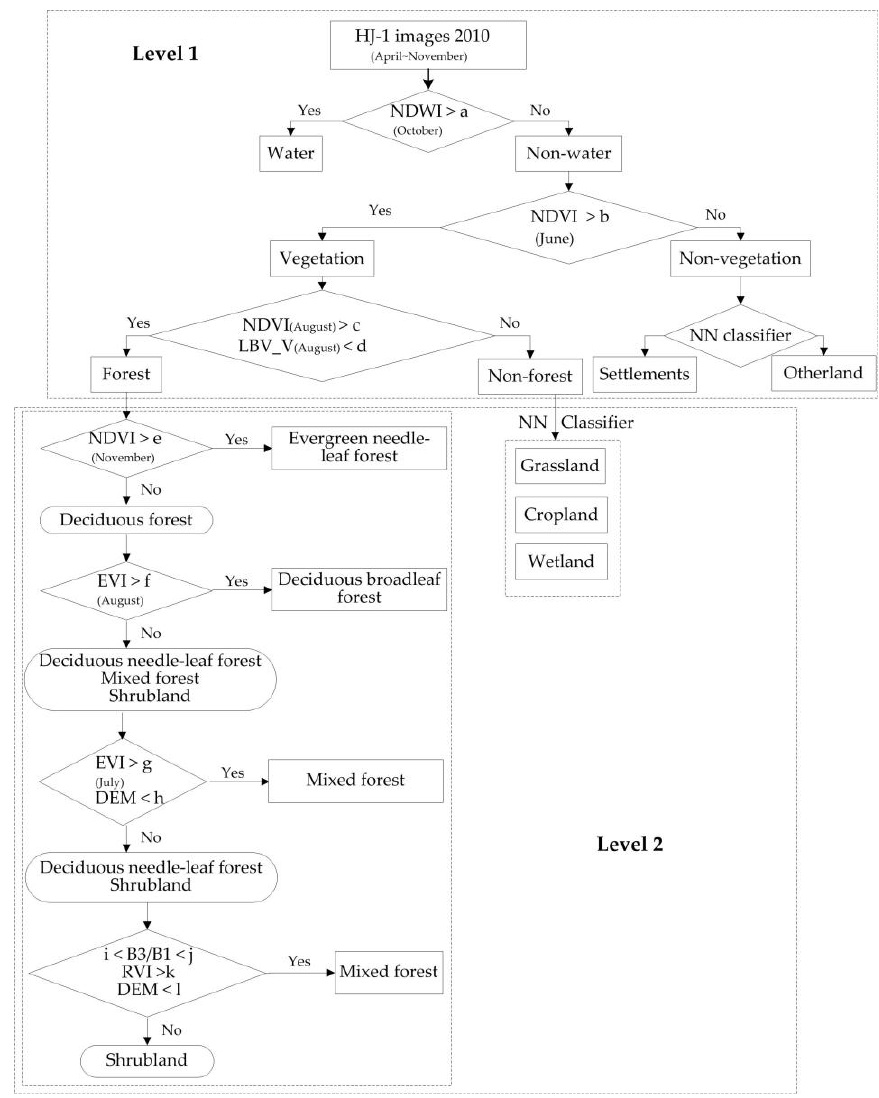
Figure 4. Forest classification based on multi-temporal images and an object-oriented method (a, b, c, d, e, f, g, h, i, j, k, l represents threshold at each decision tree node, respectively).